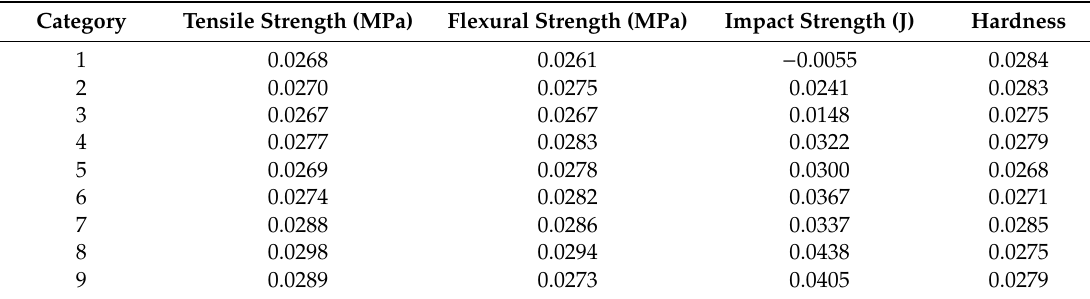
Table 6. Normalized S / N